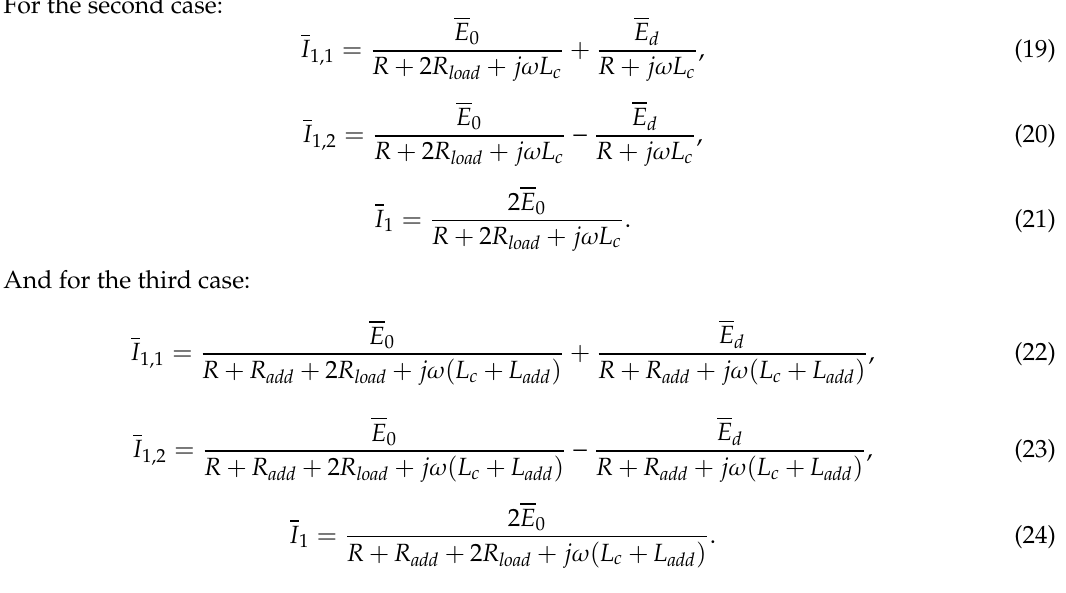
Table 3. EMF model parameter identification.